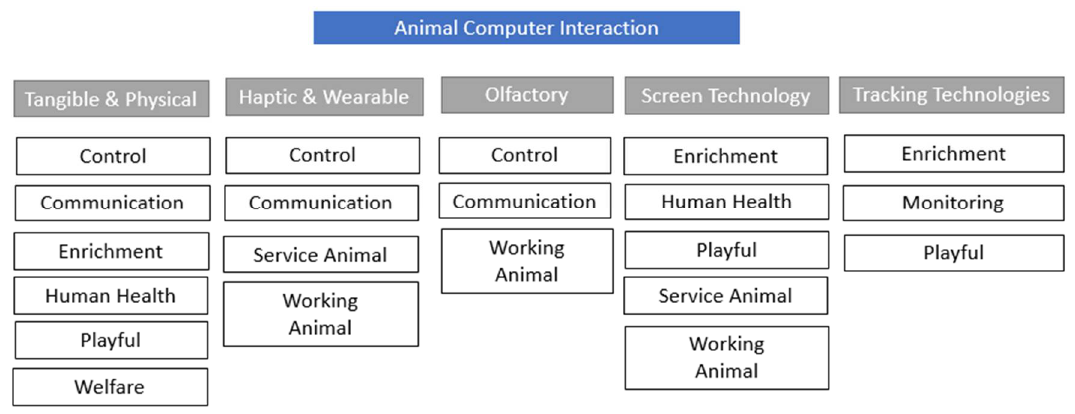
Figure 2. Framework for technologies in ACI (building from Jukan et al. [18]).